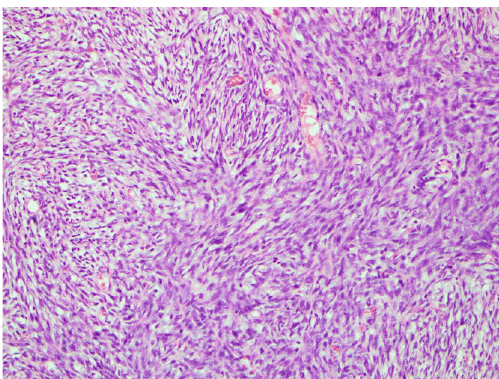
Figure 1: H&E 100x showing microscopically in fi ltrating tumour composed of fascicles of spindle cells with moderate to severe nuclear pleomorphism and increased mitotic activity in a prominent storiform pattern.